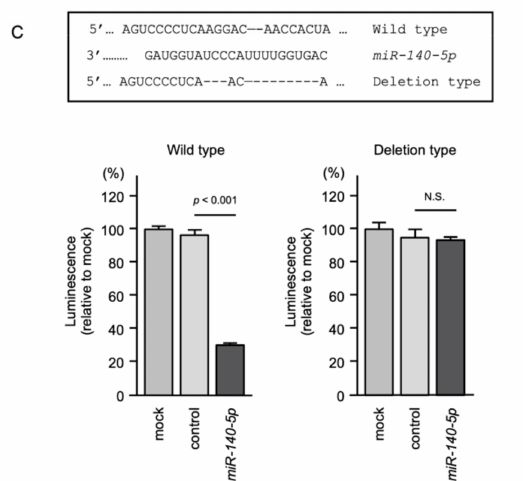
Figure 9. Direct regulation of CORO2A expression by miR-140-5p in OSCC cells. ( A ) Real-time PCR showing the significantly reduced expression of CORO2A mRNA at 48 h after miR-140-5p transfection in SAS and HSC-3 cells. Expression of GAPDH was used as an internal control. ( B ) Western blot showing reduced expression of the CORO2A protein at 48 h after miR-140-5p transfection in SAS and HSC-3 cells. Expression of GAPDH was used as an internal control. ( C ) TargetScan database shows that a single putative miR-140-5p binding site predicts the 3 (cid:48) UTR of CORO2A sequence (upper panel). Dual-luciferase reporter assays showed reduced luminescence activity after co-transfection of the wild-type vector and miR-140-5p in HSC-3 cells (lower panel). Normalized data were calculated as the Renilla/firefly luciferase activity ratio (N.S., not significant).